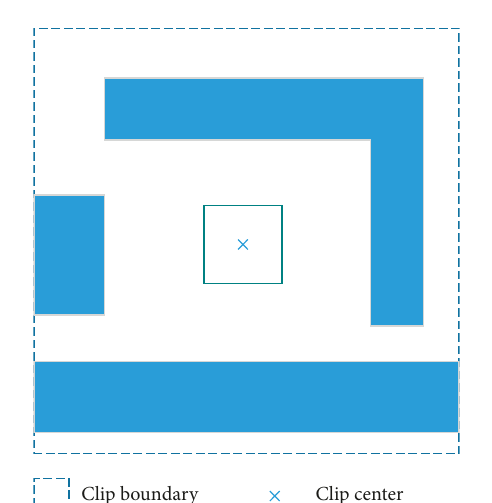
Figure 1: Sample layout.